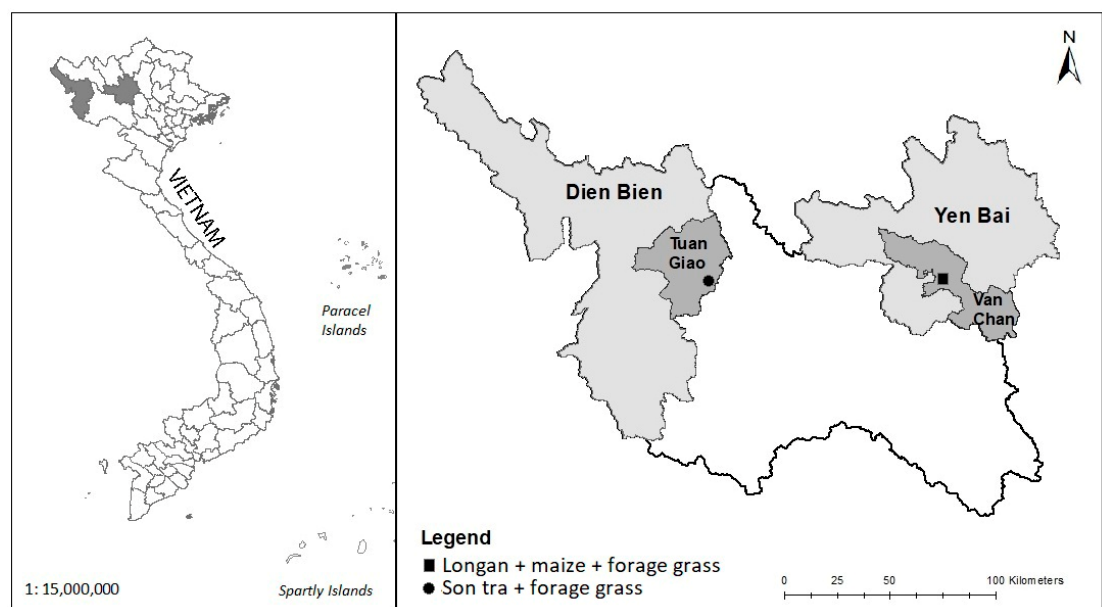
Figure 1. Location of the agroforestry experiments with longan-maize-forage grass in Van Chan District, Yen Bai province, and son tra-forage grass in Tuan Giao District, Dien Bien province, north-west Vietnam. Replicate trials were established on three farms in each district.